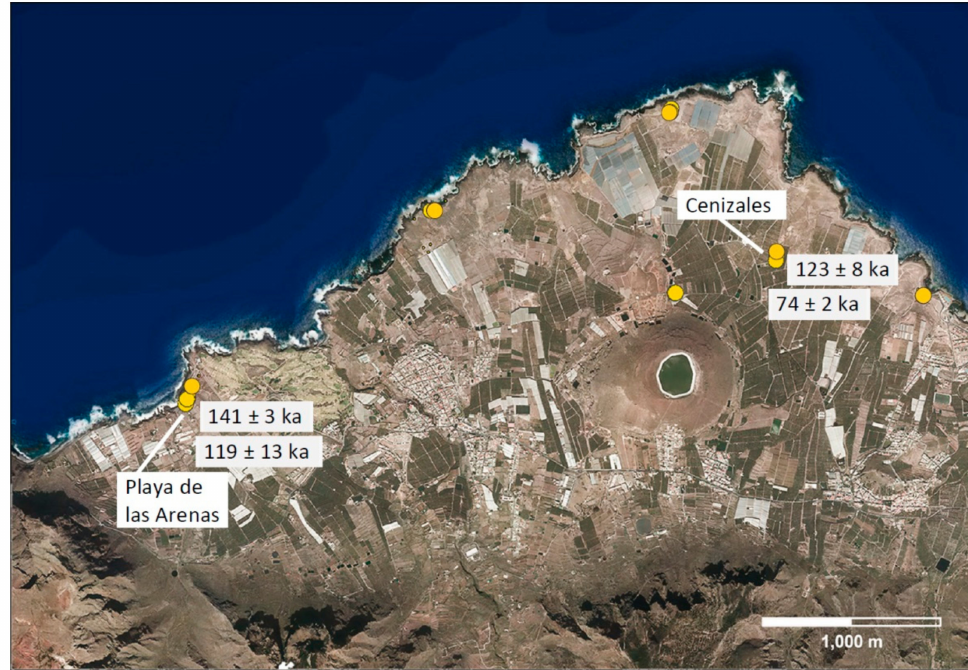
Figure 5. Isla Baja tsunami deposits. The main outcrop is located at Playa de las Arenas. Other outcrops, including Cenizales, the most inland outcrop, are also marked by yellow dots. Ages obtained in this study by AAR analysis are indicated. PNOA